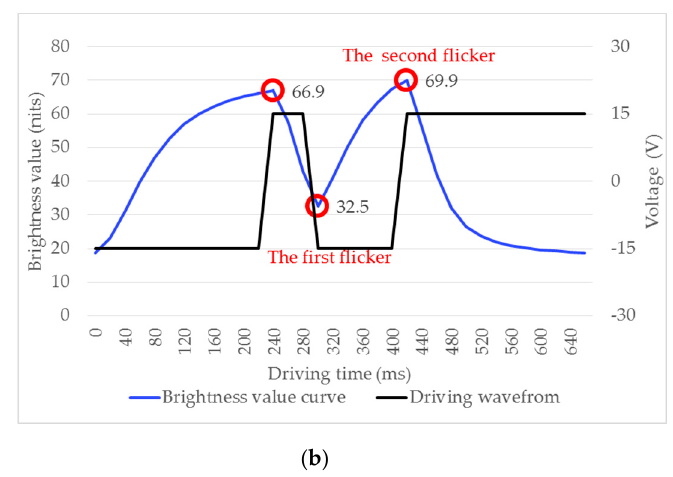
Figure 15. The change curve of EPD brightness. ( a ) When the EPD was driven by the conventional driving waveform. ( b ) When the EPD was driven by the proposed driving waveform.